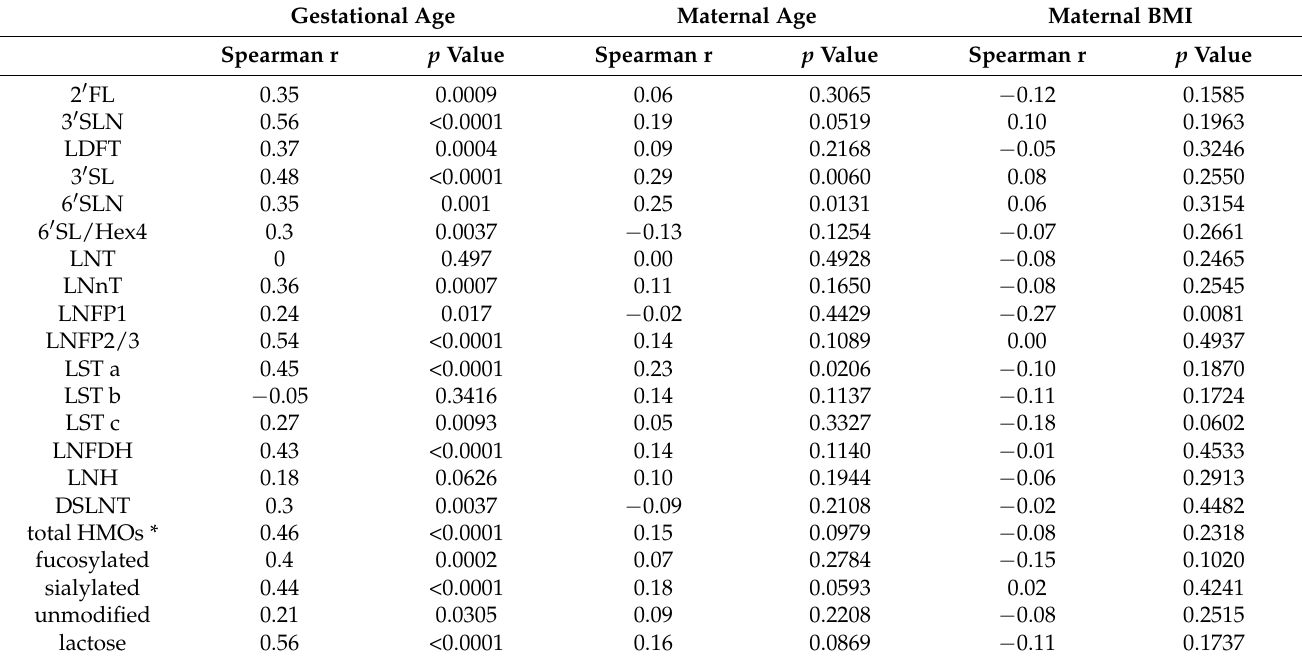
Table 3. Spearman correlations between gestational age (in weeks), maternal age (in years), and maternal BMI (kg/m 2 ), and individual and grouped HMOs (in